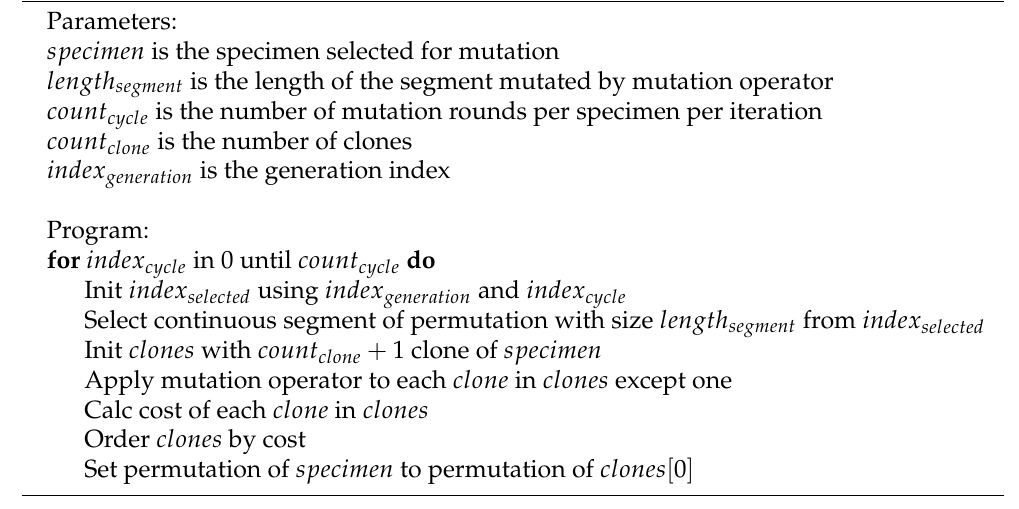
Algorithm 5 Bacterial mutation on a specimen